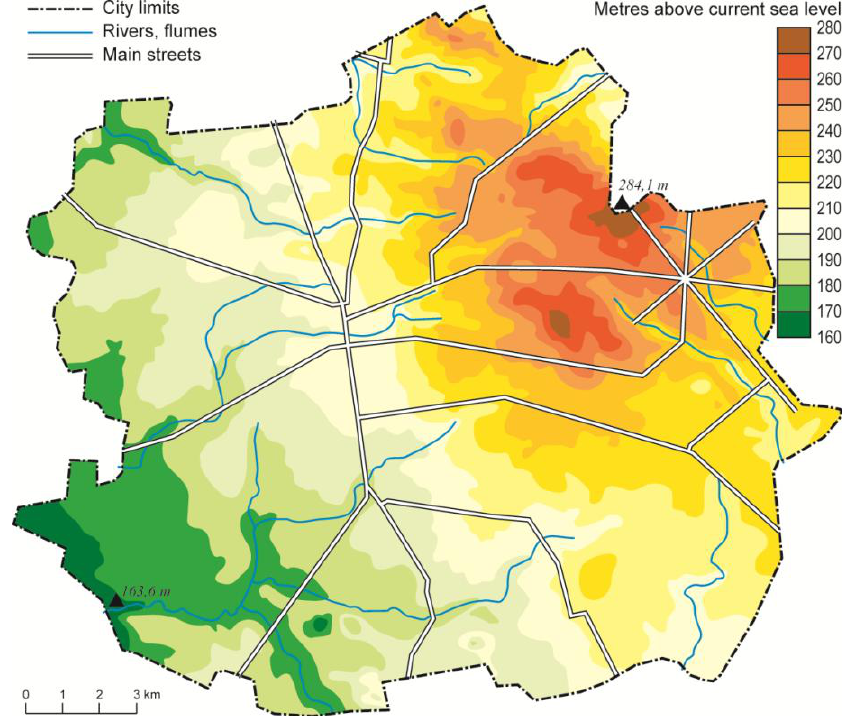
Fig. 1. Łódź – the height above sea level (source: Szkurłat,